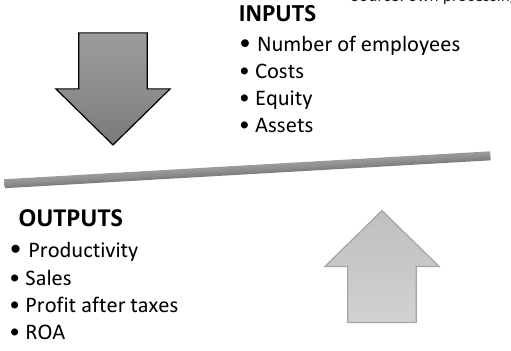
Figure 2. Model 1. Strategy “lowest costs” Figure 3. Model 2. Strategy “innovation”